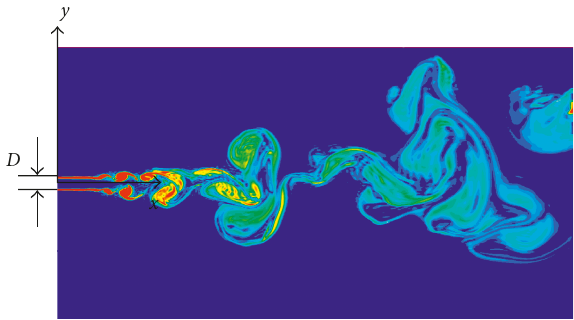
Figure 1: Schematic diagram of vortices in jet